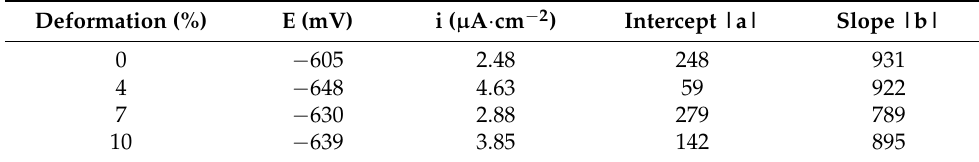
Table 2. Data extracted from the Tafel polarization curves in Figure 3.